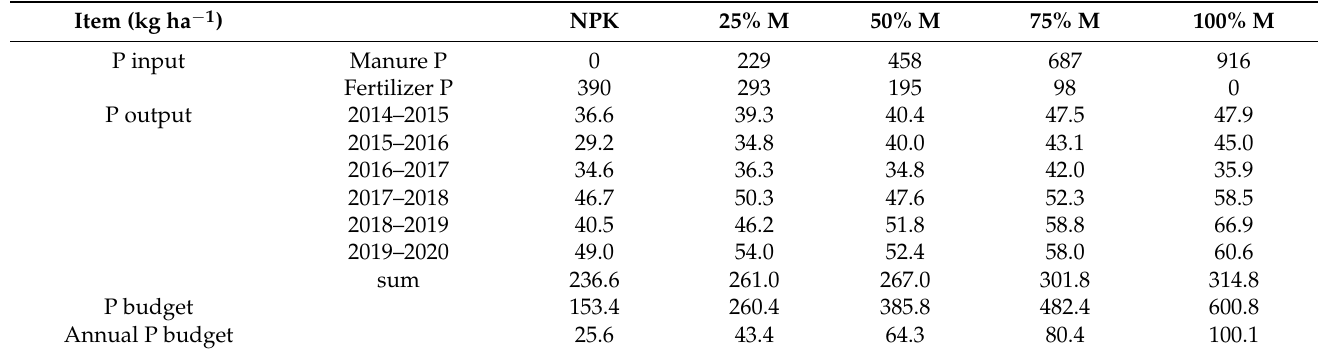
Table 4. Apparent phosphorus balance of winter wheat–summer maize cropping system under different fertilization treatments during